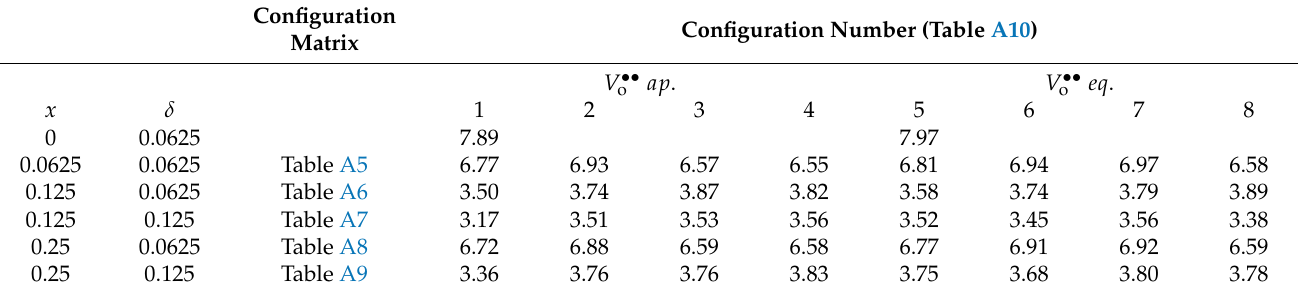
Table 5. Oxygen vacancy ( apical or equatorial , Table A1) formation energy in La 1- x Sr x ScO 3- δ , in eV per one vacancy. Corresponding spatial distribution of Sr cations as in Tables A3 and A4 and   •• as in Tables A5–A8. For δ = 0.0625 a single vacancy was introduced as in Tables A5, A6 and A8 . For δ = 0.125, a two vacancies were introduced as in Tables A7 and A9.